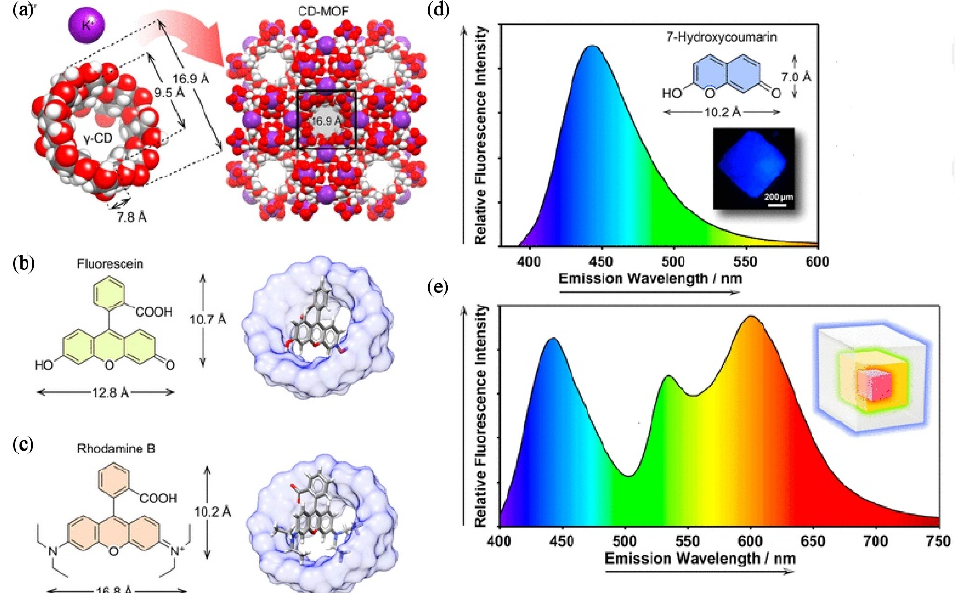
Figure 2. ( a ) γ -CD and formation of CD-MOF; ( b ) structure of FL; ( c ) structure of RhB; ( d ) fluores- cence emission spectrum of CD-MOF ⊃ 7-HCm; ( e ) fluorescence emission spectrum of CD-MOF ⊃